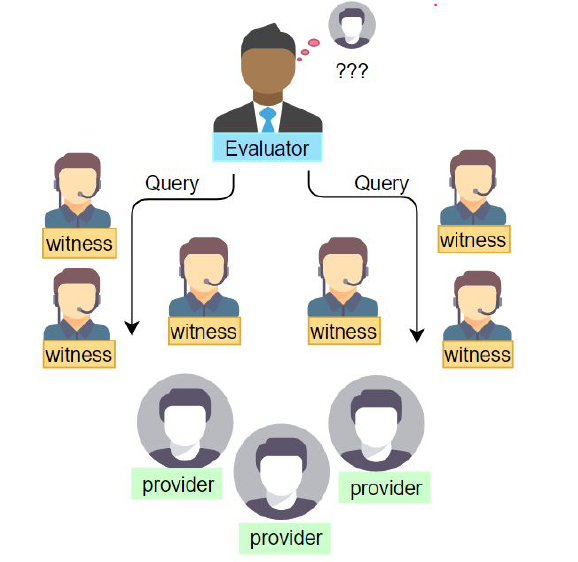
Figure 2. Trust evaluation in